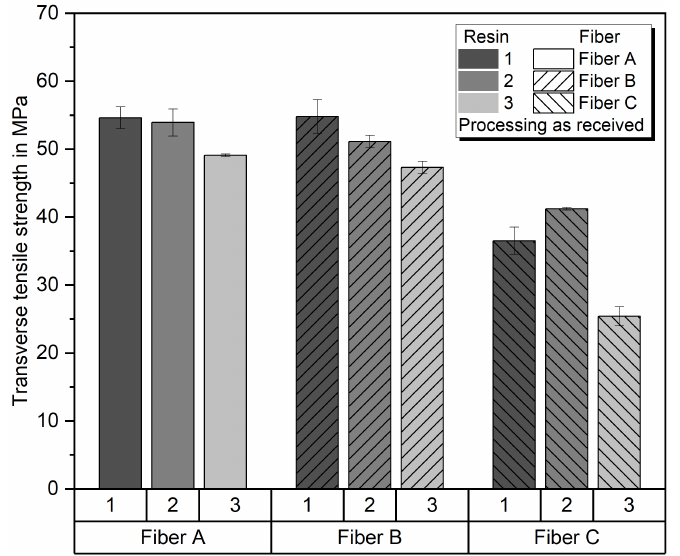
Figure 5. Transverse tensile strength of fibers A–C with regard to the use of different epoxy resins (with amine hardeners) as matrix materials.